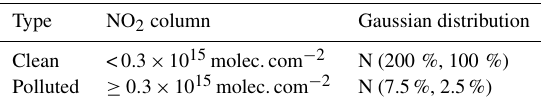
Table 4. Relative observation uncertainty σ rel in synthetic TEMPO NO 2 column for each